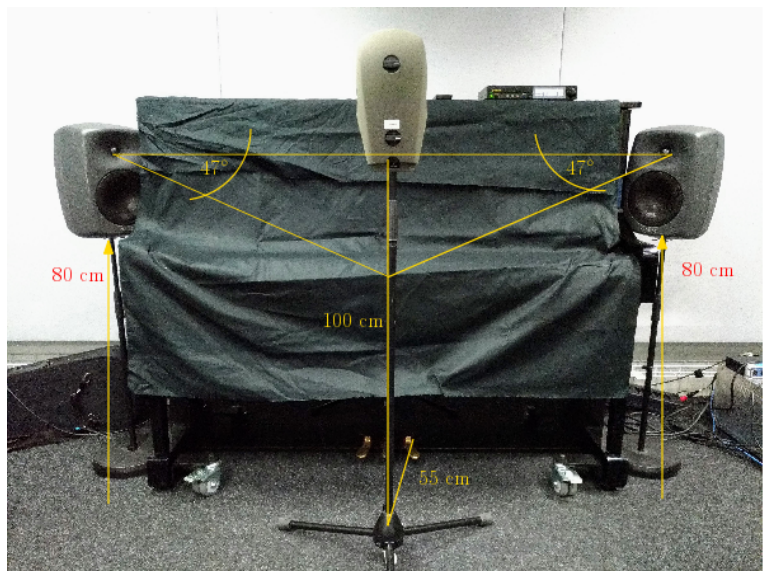
Figure 5. Upright piano recording setup.